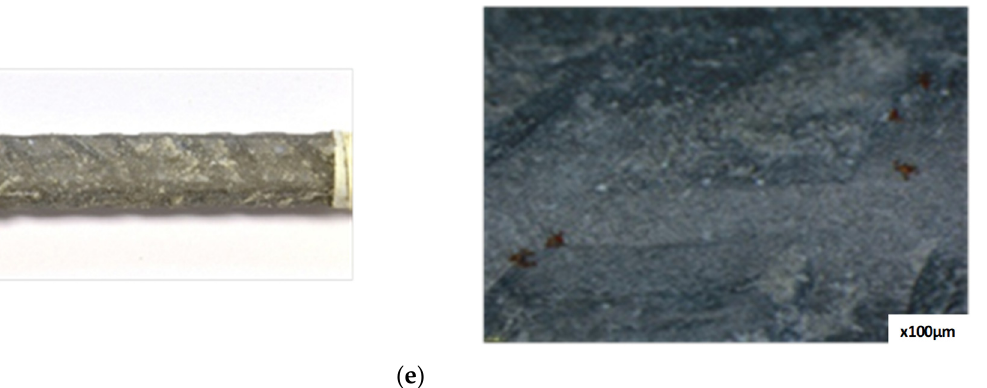
Figure 7. Visual and microscope examination of chloride-contaminated mortars, ( a ) reference; ( b ) 0.088% of AA; ( c ) 0.044% of AA; ( d ) 0.009% of AA; ( e ) 2.6% of NO 2 − .